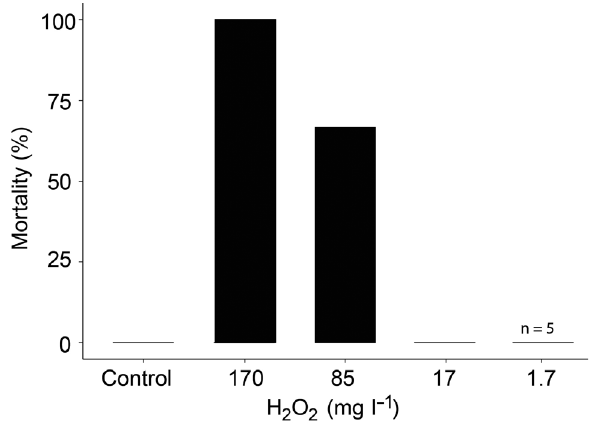
Fig. 1. Mortality of juvenile Saccharina latissima plants 15 d after 1 h exposure to 5 different H 2 O 2 concentrations, in- cluding control (n = 6 unless otherwise